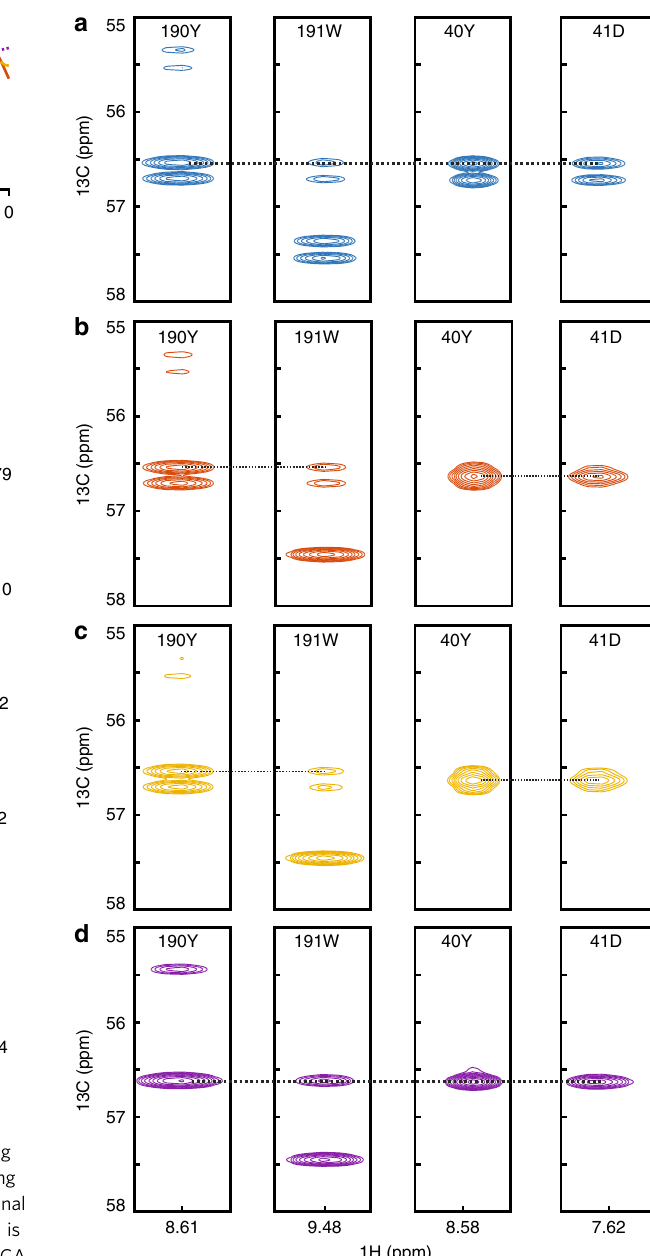
Fig. 4 Using BADCOP1 – 3 line shapes and splitting patterns for sequential matching. In the 3D HNCA of HCAii, tyrosines 190Y and 40Y are overlapped in the C α dimension, as are the sequential peaks in their respective i + 1 residues. This produces an ambiguity in the sequential assignment, which could be resolved using an HNCACB experiment. a The four HNCA strips, recorded using GOODCOP. All peaks are doublets and the chemical shifts are the same, generating an ambiguity in the sequential assignment. b Using BADCOP1, two of the peaks are partially decoupled and become broad singlets. The other two remain doublets. This resolves the ambiguity in the sequential matching process and implies that 190Y and 40Y have different C β chemical shifts. c Using BADCOP2, the same decoupling pattern appears in this case. In some cases (depending on C β shift), different line shapes are observed with BADCOP1 vs. BADCOP2. d With BADCOP3, all the peaks appear as singlets with doubled height compared with the doublets. The sequential peak for 190Y at 55.4 p.p.m. is more clearly visible above the noise. All acquisition, processing, and display settings are the same for the four spectra